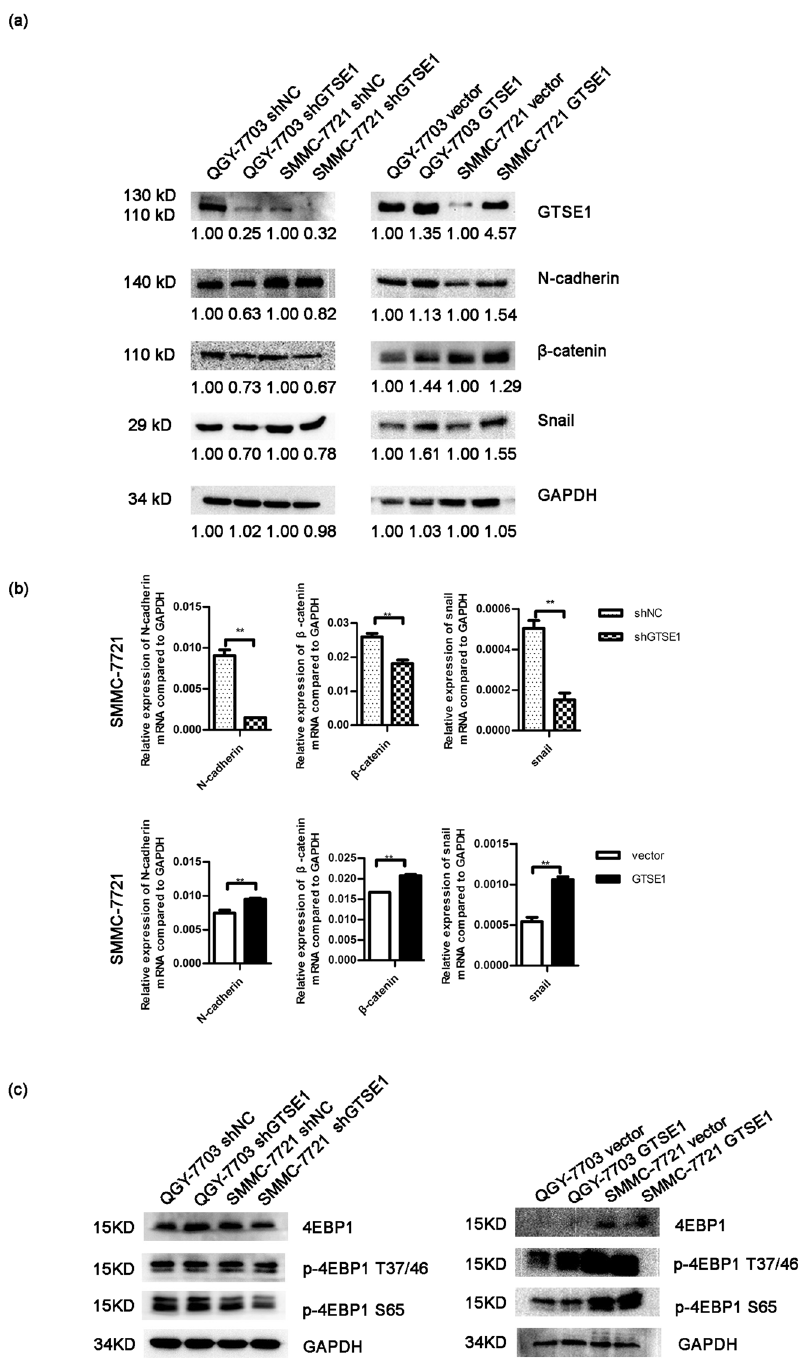
Figure 5. GTSE1 regulates EMT in vitro . ( a ) The protein levels of GTSE1, N-cadherin, β -catenin, and Snail were determined by western blotting in QGY-7703 and SMMC-7721 cells stably transfected with shGTSE1 or GTSE1 or control. Relative protein fold changes compared with the control are marked below. Original data are presented in Supplementary Fig. 4. ( b ) The mRNA expression levels of N-cadherin, β -catenin, and Snail were detected by qPCR in SMMC-7721. ( c ) The protein levels of 4EBP1, p-4EBP1 (T37/46), and p-4EBP1 (S65) were tested by western blotting in QGY-7703 and SMMC-7721. Original data are presented in Supplementary Fig.